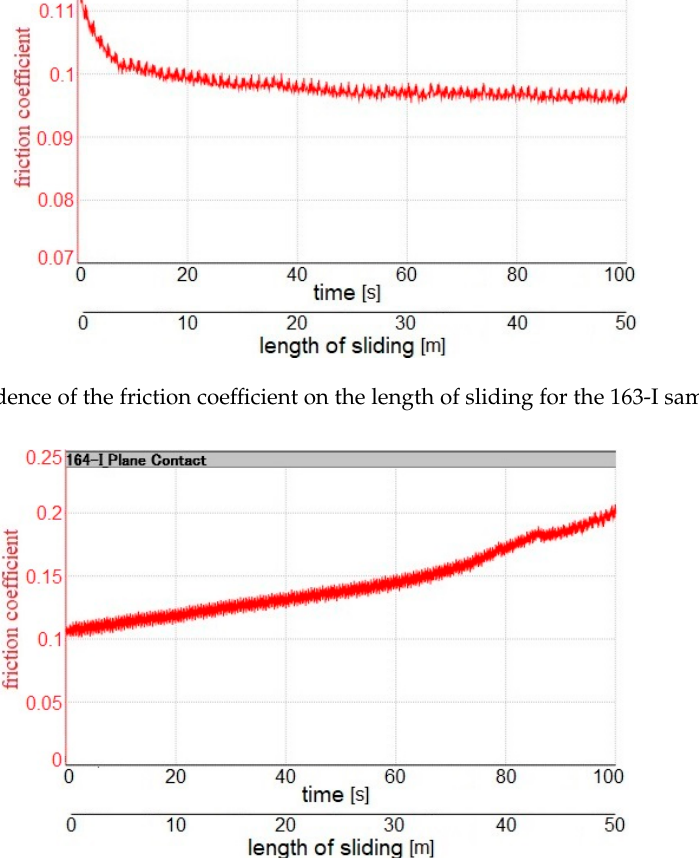
Figure 9. Dependence of the friction coefficient on the length of sliding for the 164-I sample surface.